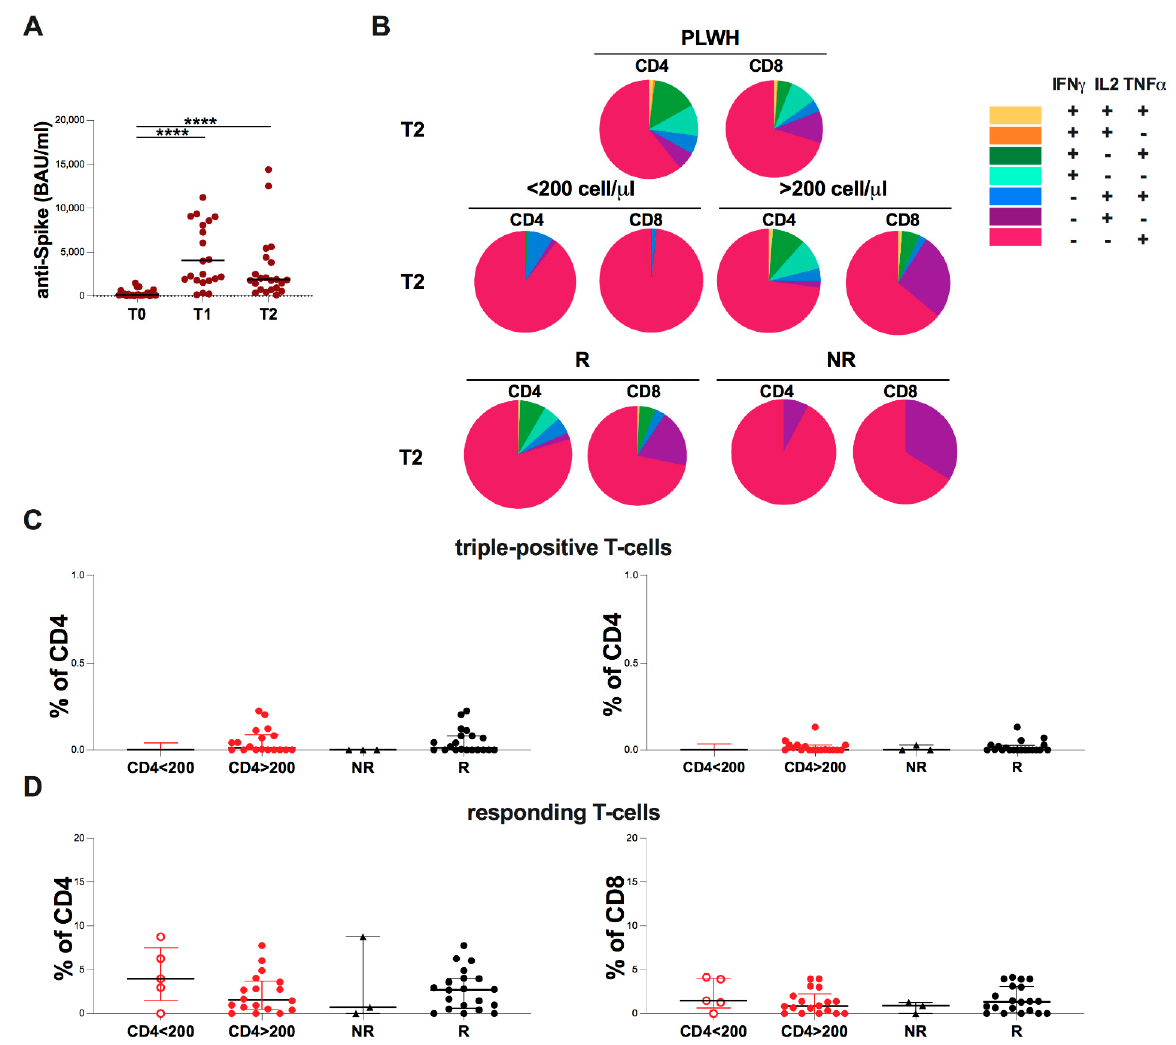
Figure 5. Evaluation of S-specific humoral and T-cell response in PLWH at T2. ( A ) Anti-S antibody levels in PLWH. The cross-sectional evaluation was made using the nonparametric Mann-Whitney test. Data are shown as median (lines). ( B ) Frequency of CD4 and CD8 T cells producing all combinations of IFN γ , IL2, and TNF α in PLWH and in PLWH stratified according to CD4 cell count and according to humoral response into NR and R. ( C ) Percentage of triple-positive T − cells levels in PLWH stratified according to current CD4 cell count and humoral response. The differences between CD4 > 200 and CD4 < 200 and between R and NR groups were evaluated using the nonparametric Mann − Whitney test. Data are shown as median (lines). ( D ) Percentage of responding T-cells levels in PLWH stratified according to current CD4 cell count and humoral response. The differences between CD4 > 200 and CD4 < 200 and between R and NR groups were evaluated using the nonparametric Mann − Whitney test. Data are shown as median (lines). Statistical significance (p) is reported in the graphics. **** p < 0.0001.